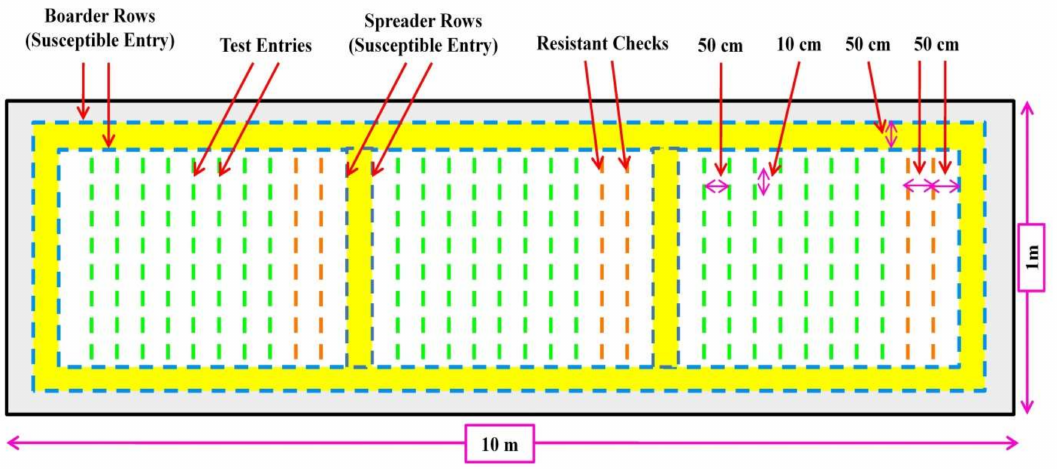
Figure 3. Schematic representation of Uniform Blast Nursery for screening of rice genotypes for blast